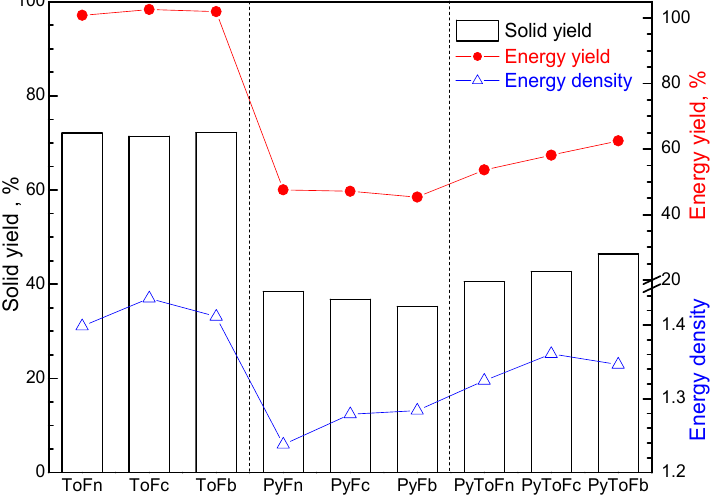
Figure 3. Solid yield, energy density and energy yield from thermal processing of fir forestry waste.